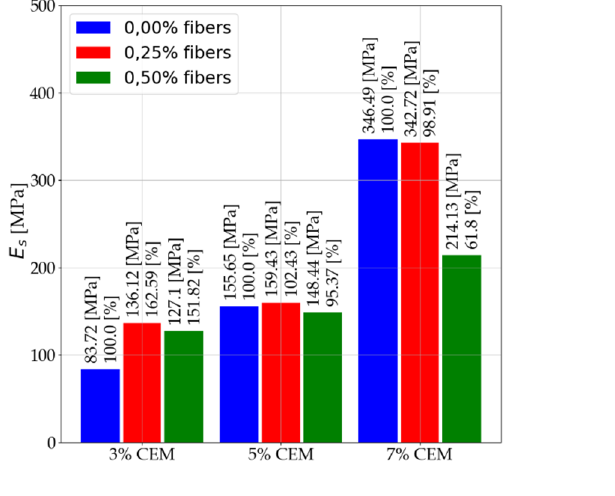
Figure 7. Values of secant modulus E s after 28 days of care ( a ) before interpretation and ( b ) after interpretation.